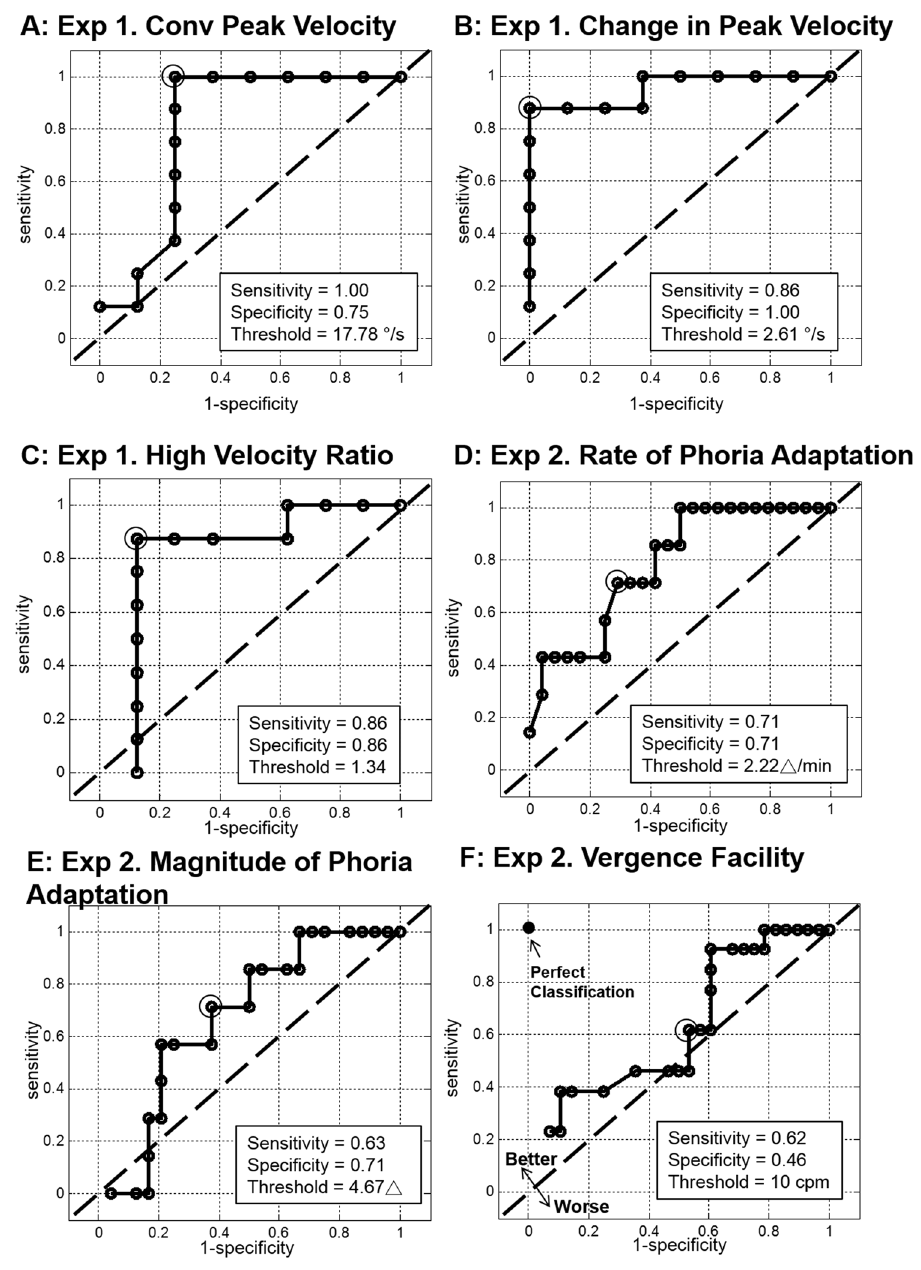
Figure 8. The line of no discrimination (dashed black line) and the receiver operating characteristic (ROC) curves (solid black line) with the optimal threshold (indicated as gray circle) for PALs acceptability for the following parameters: ( A ) baseline peak velocity (accuracy = 75%), ( B ) change in convergence peak velocity (accuracy = 88%), ( C ) high-velocity ratio (accuracy = 88%), ( D ) rate of phoria adaptation (accuracy = 71%), ( E ) change in phoria magnitude (accuracy = 71%), and ( F ) vergence facility (accuracy =